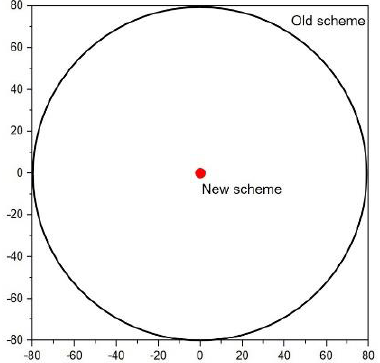
Figure 28. Two models calculation flying 2000